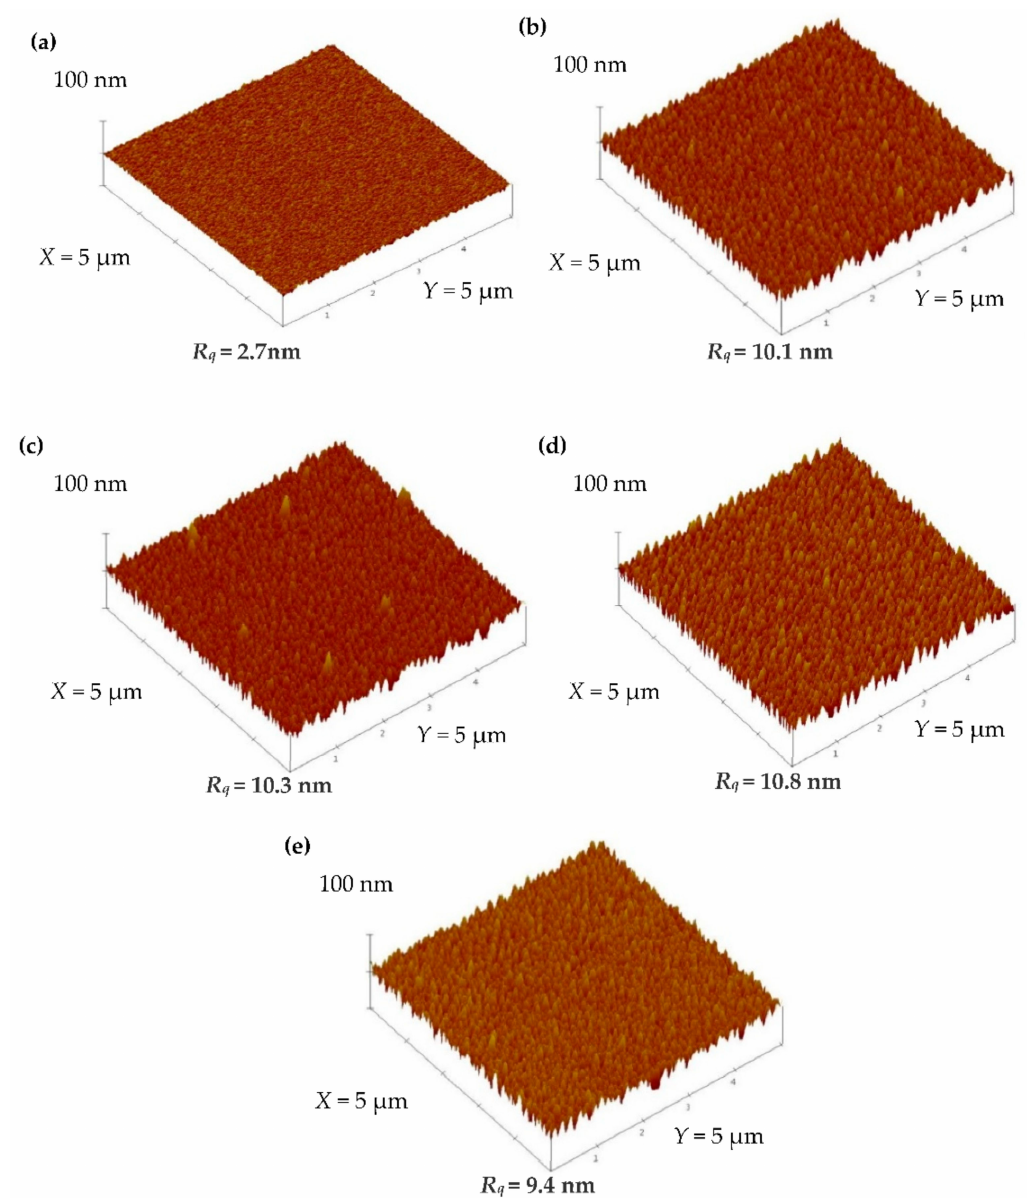
Figure 1. Surface roughness of ( a ) the as-deposited Ag film directly deposited onto the silicon substrate and the films annealed at ( b ) 300, ( c ) 400, ( d ) 500, and ( e ) 600 ◦ C under nitrogen ambient for 1 min, examined by AFM